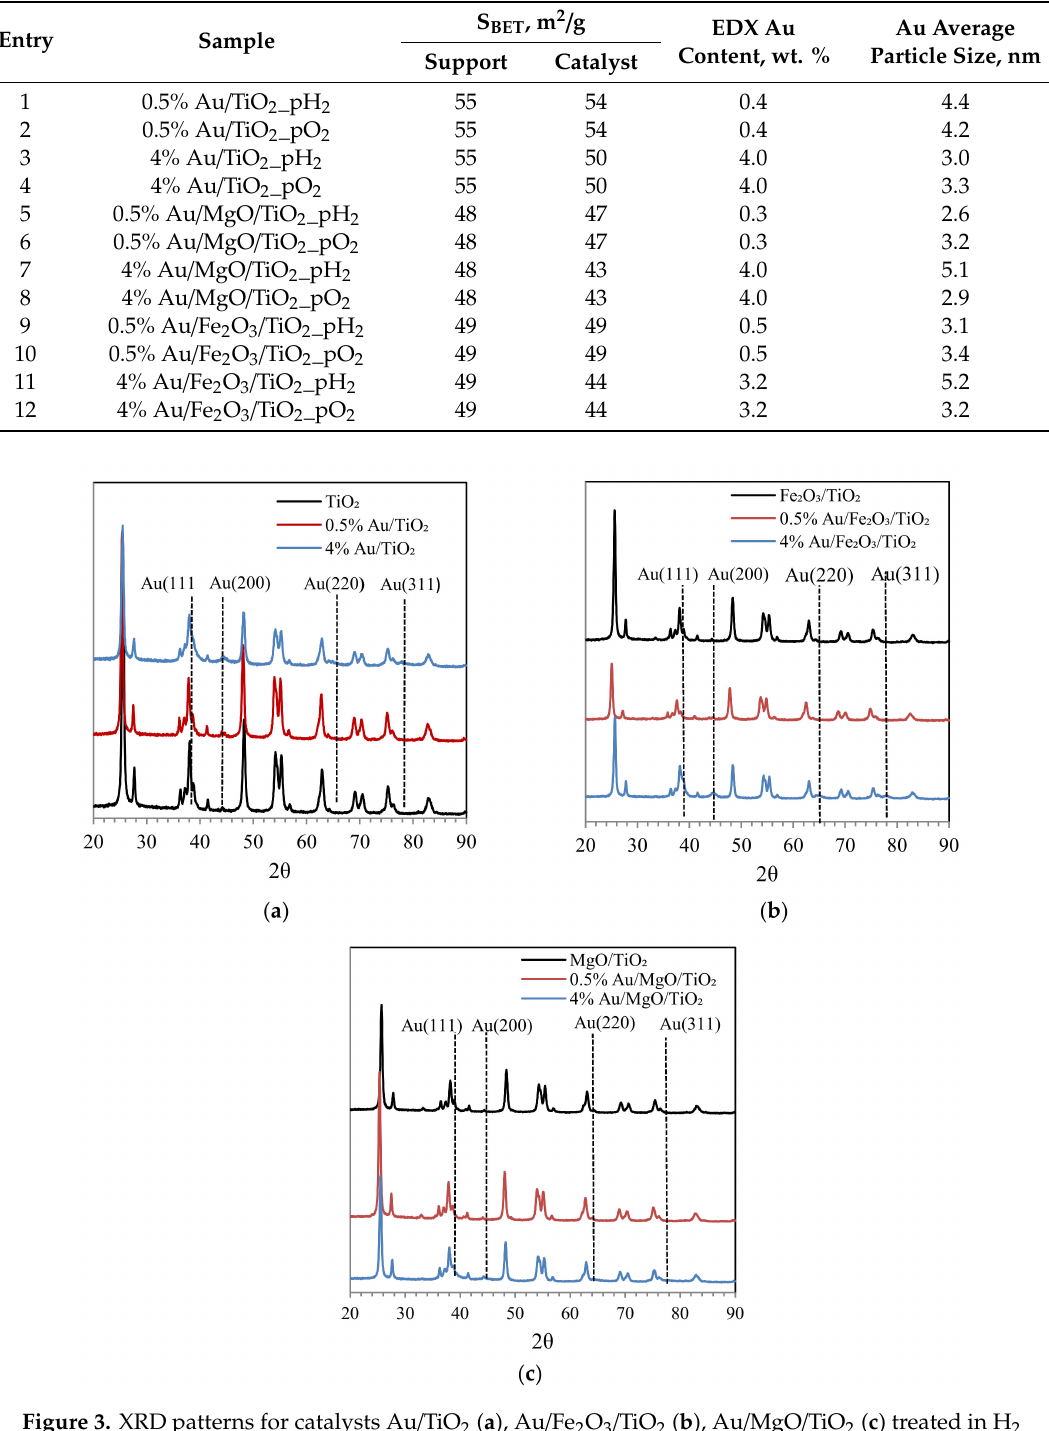
Figure 3. XRD patterns for catalysts Au / TiO 2 ( a ), Au / Fe 2 O 3 / TiO 2 ( b ), Au / MgO / TiO 2 ( c ) treated in H 2 (300 ◦ C, 1 h) and their corresponding